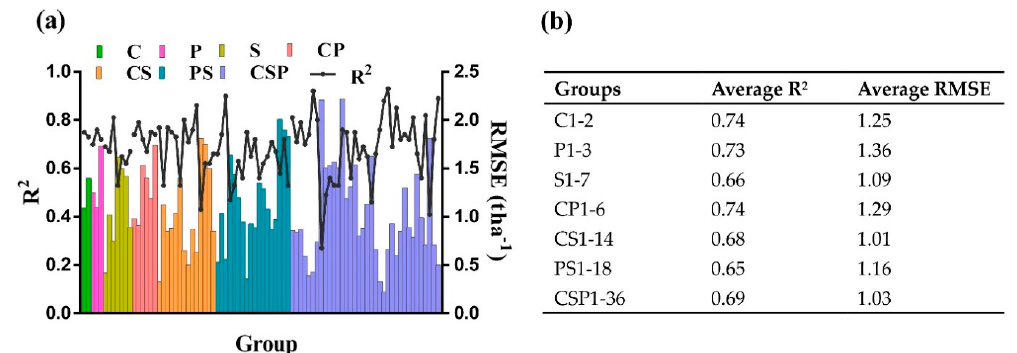
7, CP1-6, CS1-14, PS1-18 and CSP1-36 represent the groupings of corresponding random effects,